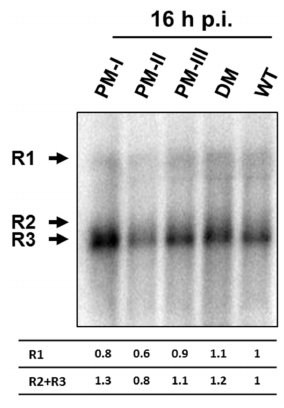
Figure 7. Accumulation of viral transcripts in infected NB-324k cells. NB-324k cell cultures infected (MOI of 3 PFU/cell) were incubated for 16 h and processed for Northern blotting analysis. The positions of viral R1, R2, and R3 mRNAs are indicated with